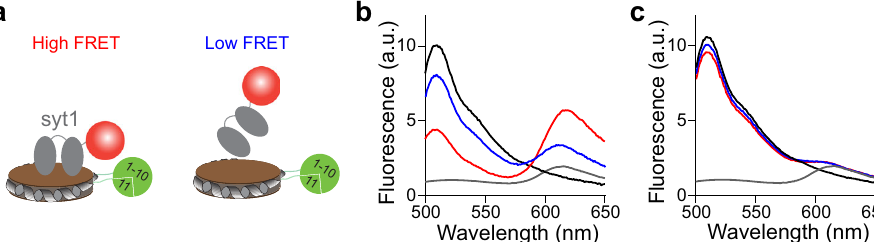
Fig. 2 Using isenND to characterize protein-lipid interactions. a Diagram for the FRET between syt1-mcherry and isenND. b , c Representative fl uorescence spectrum of syt1-mcherry (gray) binding to isenND (black). FRET was observed upon incubation of syt1-mcherry with isenND containing PS lipids in the presence (red) and absence (blue) of 0.5 mM Ca 2 + ( b ). In contrast, FRET was not observed between syt1-mcherry and isenND containing only PC lipids ( c ). Data are shown as mean ± s.d., n = 3 independent